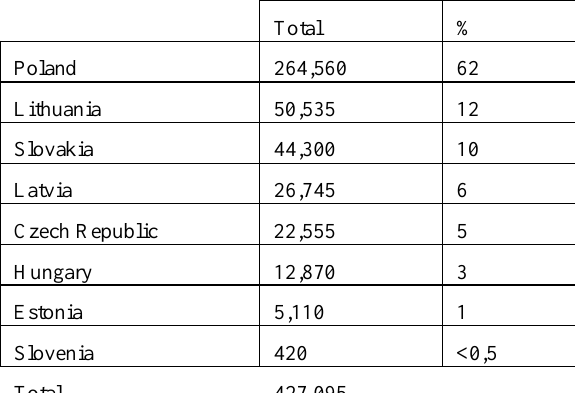
Table 1 . Nationality of Applicants to UK Worker Registration Scheme (1 st May 2004 – 30 th June 2006)